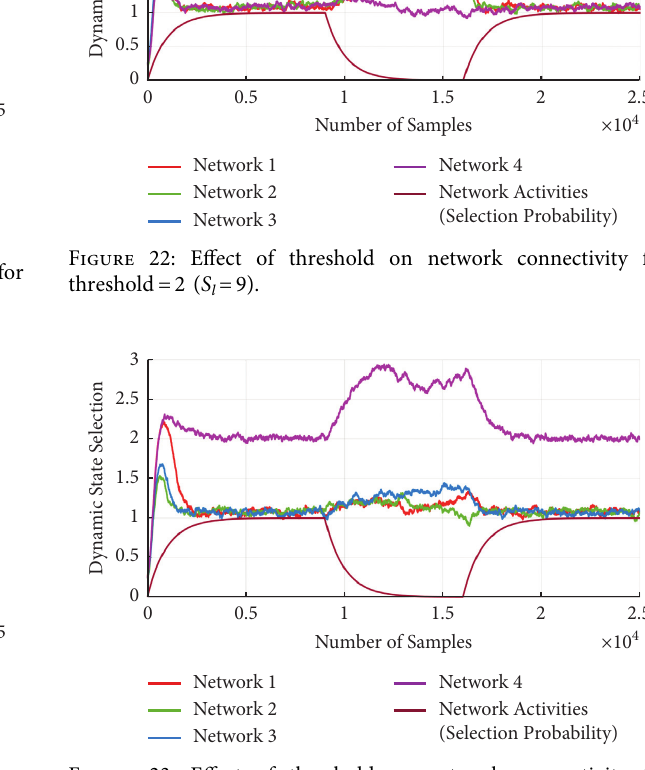
Figure 20: Effect of threshold on network connectivity for threshold � 2 ( S l � 7).